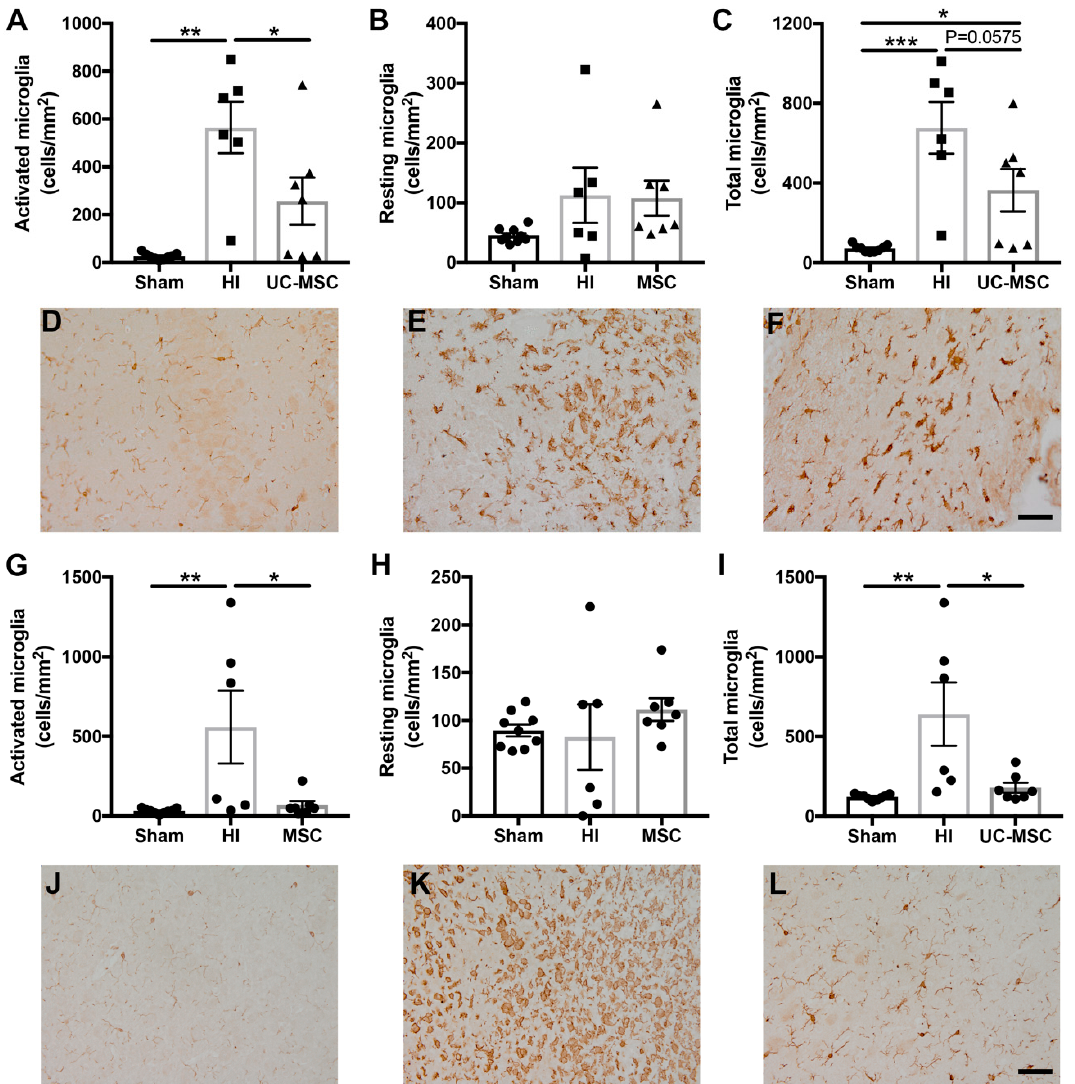
Figure 4. Microglial activation is increased following neonatal HI brain injury and reduced by UC-MSC treatment. Iba-1 immunohistochemistry was performed to identify microglia in the hippocampus, somatosensory cortex and periventricular striatum region of the brain. ( A ) Activated microglia, ( B ) resting microglia and ( C ) total microglia in the hippocampus. Representative images of Iba-1 staining in the hippocampus for ( D ) sham, ( E ) HI and ( F ) MSC treatment; ( G ) Activated microglia, ( H ) resting microglia, and ( I ) total microglia in the somatosensory cortex. Representative images of Iba-1 staining in the somatosensory cortex for ( J ) sham, ( K ) HI and ( L ) MSC treatment. All images were taken at 400 × magnification, scale bar = 500 µ m ( n = 6–9 rats per group, * p < 0.05, ** p < 0.01, *** p < 0.001).